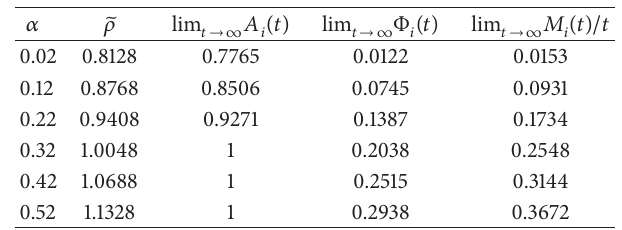
Table 2: The effects of batch order entering probability 𝑝 during optional jobs on production facility indices (𝜆 = 0.2 , 𝜃 = 0.5 , 𝜇 = 2 , 𝛼 = 0.1 , and 𝛽 = 0.8) .